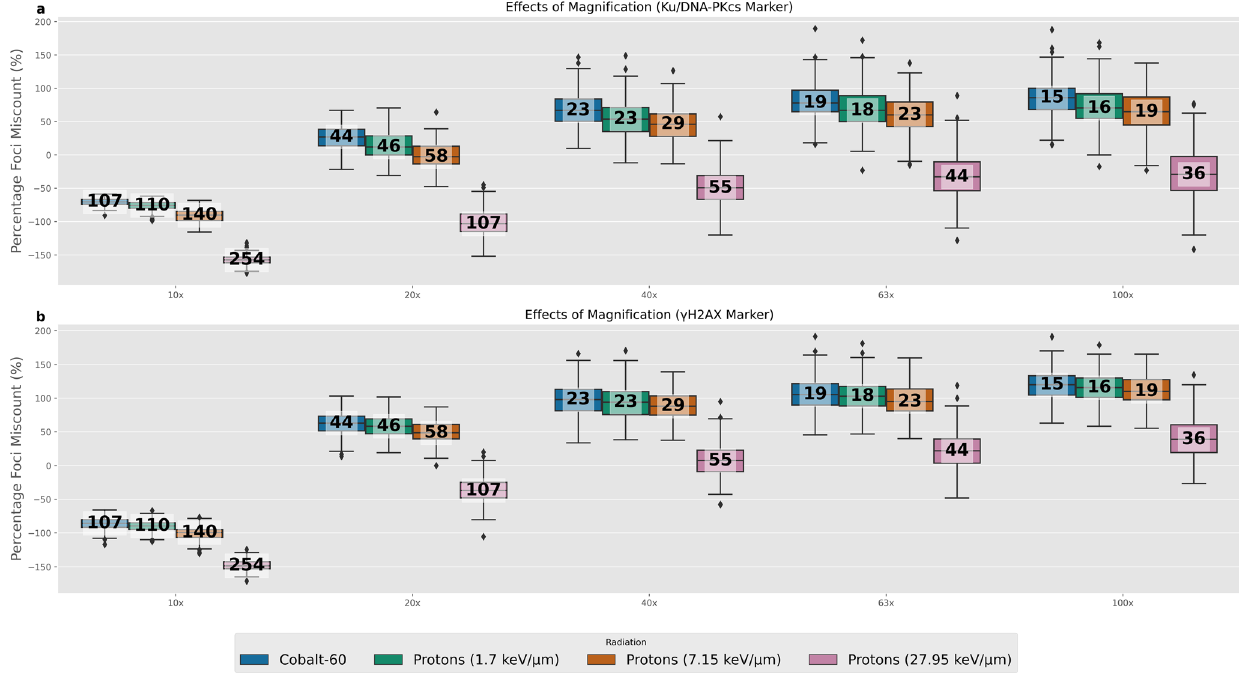
Fig. 4 Comparison of percentage miscounting at different Airyscan magni fi cations. The value shown in white within each box-plot is the actual number of DSBs within the evaluated microscope slice. This aids in giving perspective on the amount of miscounting each percentage corresponds to. a are the results when using a Ku/DNA-PKcs marker. b are the results when using an γ -H2AX marker. All microscope images are at 2 Gy dose and for the 15 min time point. There are 200 samples for each